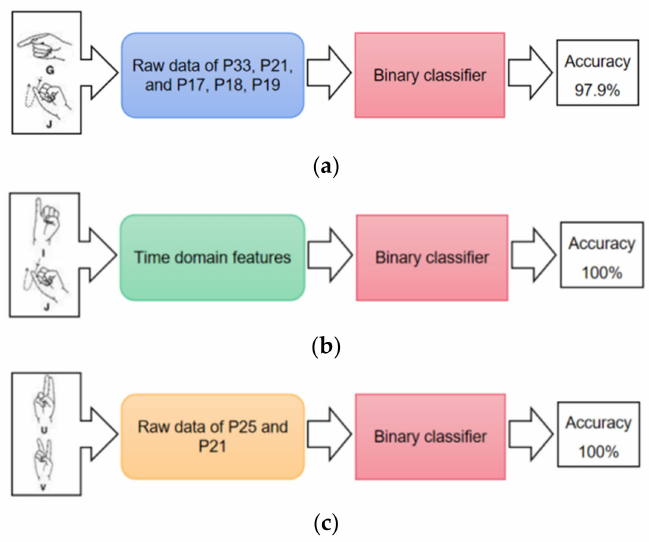
Figure 15. Binary classification of easily confused gesture groups: ( a ) “g” and “j”; ( b ) “i” and “j”; ( c ) “u” and